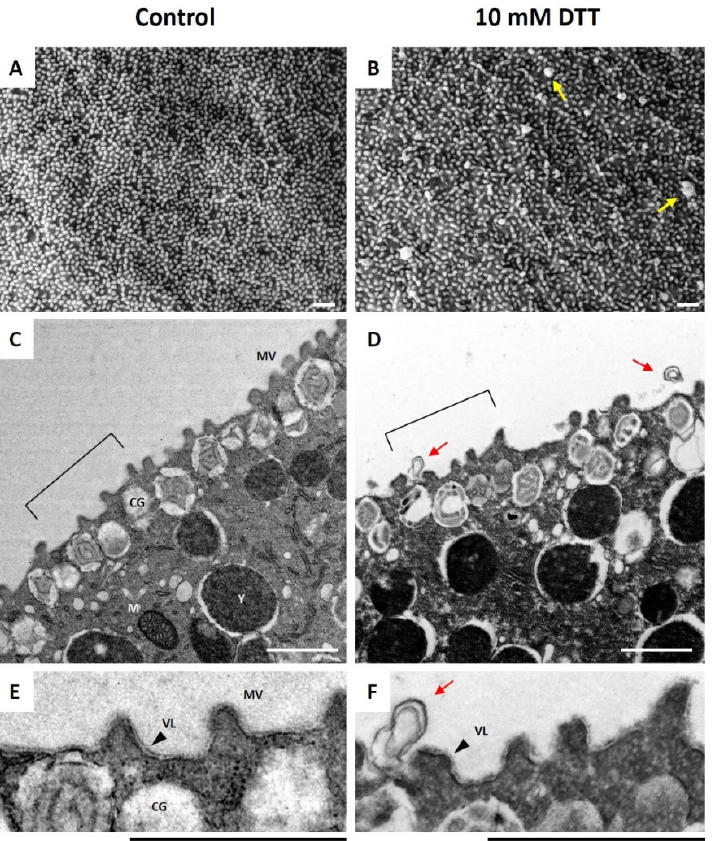
Figure 1. Ultrastructure of unfertilized sea urchin eggs at the surface after brief treatment with dithiothreitol. P. lividus eggs were exposed to 10 mM dithiothreitol (DTT) in seawater for 10 min and were subjected to analyses by electron microscopy, following the procedures described in Materials and Methods. ( A , B ) Images obtained by SEM. ( C , D ) Images obtained by TEM. Note that, after the DTT treatment, the shape of the individual microvilli (MV) became irregular and slightly thicker, and that numerous blebs were formed on the egg surface (yellow and red arrows in B , D , F ). ( E , F ) For closer examination, the areas of the TEM images marked by brackets in panels ( C , D ) are enlarged. Scale bars, 1 µ m. CG—cortical granules; MV—microvilli; M—mitochondria; Y—yolk granules; VL—vitelline